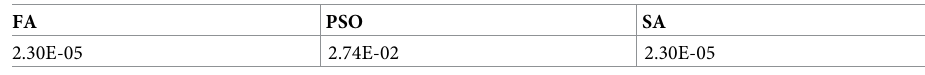
Table 6. p values of the Wilcoxon rank-sum test over 15